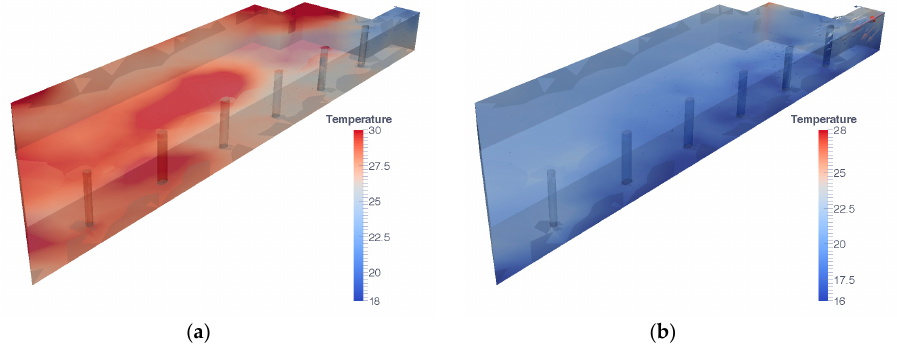
Figure 9. Case 1: Le Corbusier hypothesis. 3D image of temperature distribution at 00:00 hours on the second day of calculation. ( a ) winter; ( b ) summer.